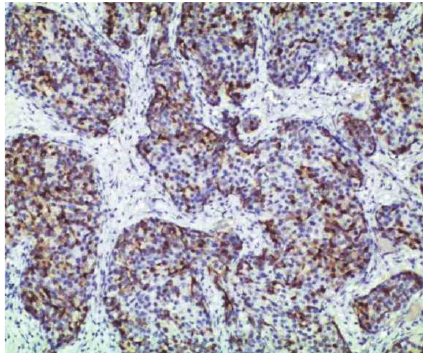
Figure 3: Lymph node with metastasis, nests of tumor cells, 50% expression of chromogranin 0 , × 40.